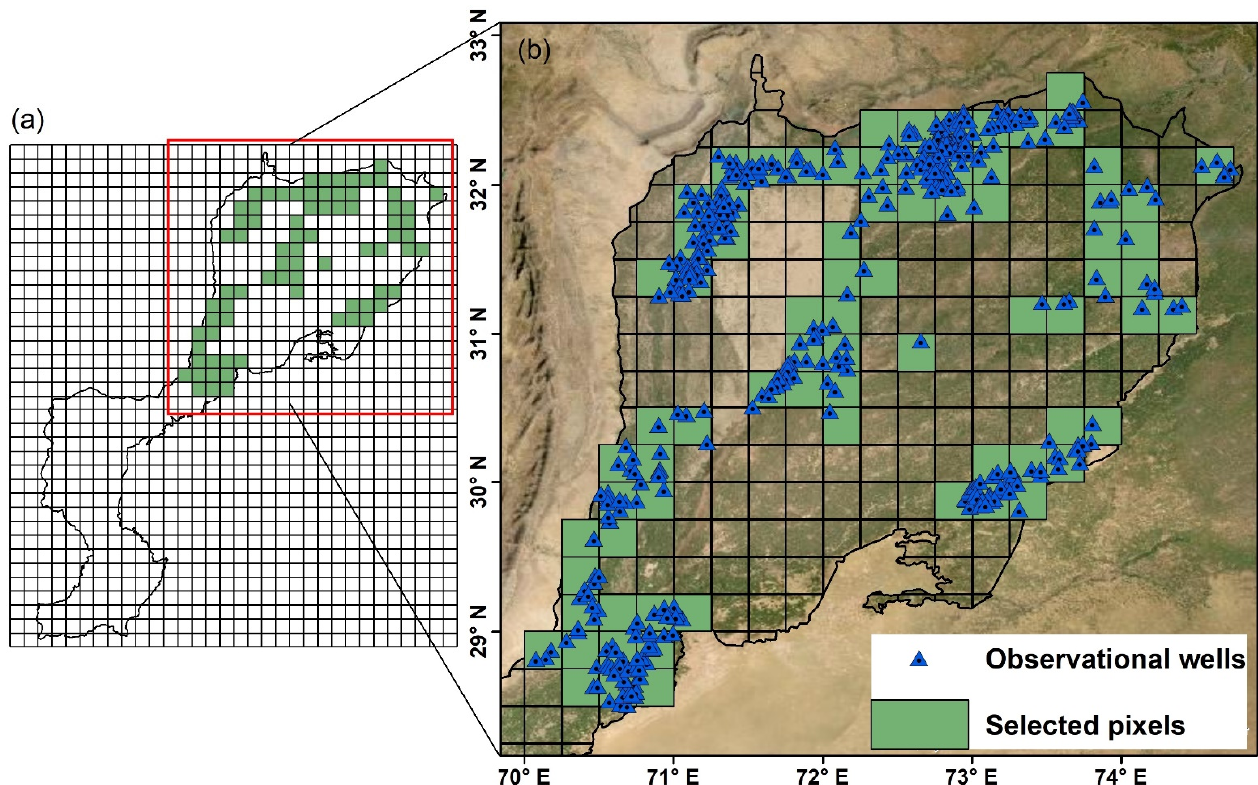
Figure 2. ( a ) Watershed mask within a 0.25° × 0.25° GRACE downscaling TWS grid. ( b ) Observational wells located in the upper IBIS.